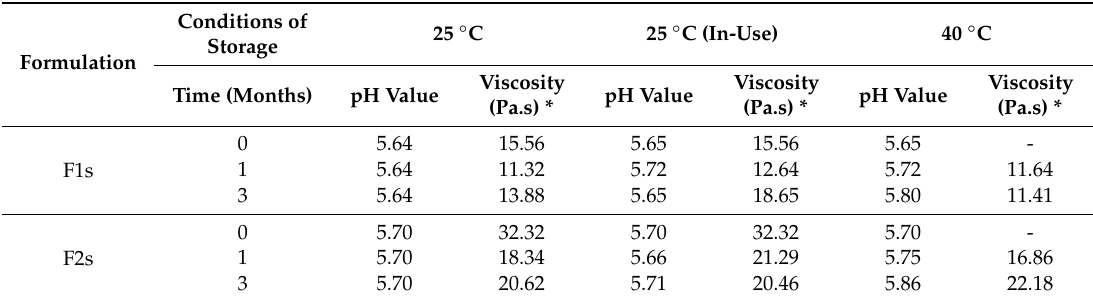
Table 3. Stability test results for formulation F1s and F2s during 3 months at (25 ± 2) ◦ C, at (40 ± 2) ◦ C / (75 ± 5)% relative humidity (RH), and 25 ◦ C (in-use).